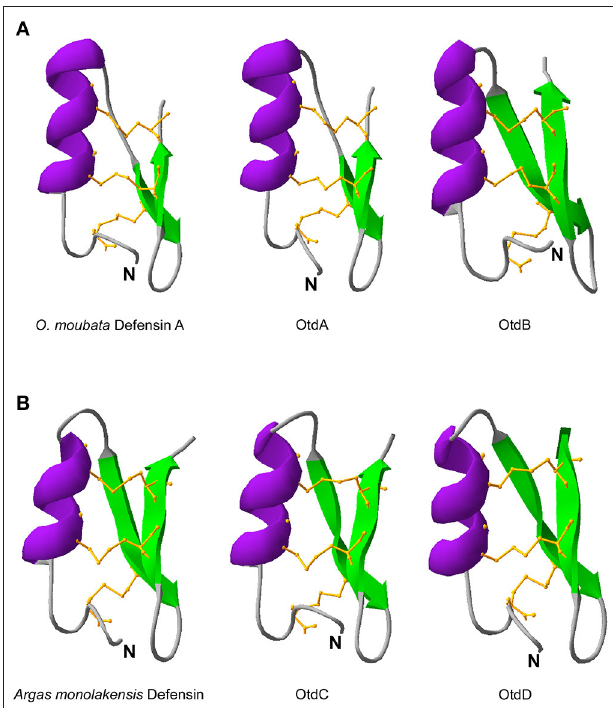
FIGURE 2 | Predicted protein structure of defensins. In (A) are the protein structure of soft tick defensins O. moubata and the two most structurally similar O. turicata defensins, OtdA, OtdB. In (B) A. monolakensis defensin is shown with the most similar O. turicata defensins, OtdC and OtdD. Structures were predicted using MODELLER and visualized using SWISS-PDB viewer. Purple represents the alpha helix, green are the beta sheets, and the orange ball and stick regions are the disulfide bridges between cysteines C1–C4, C2–C5, and C3–C6. N represents the N terminus of the